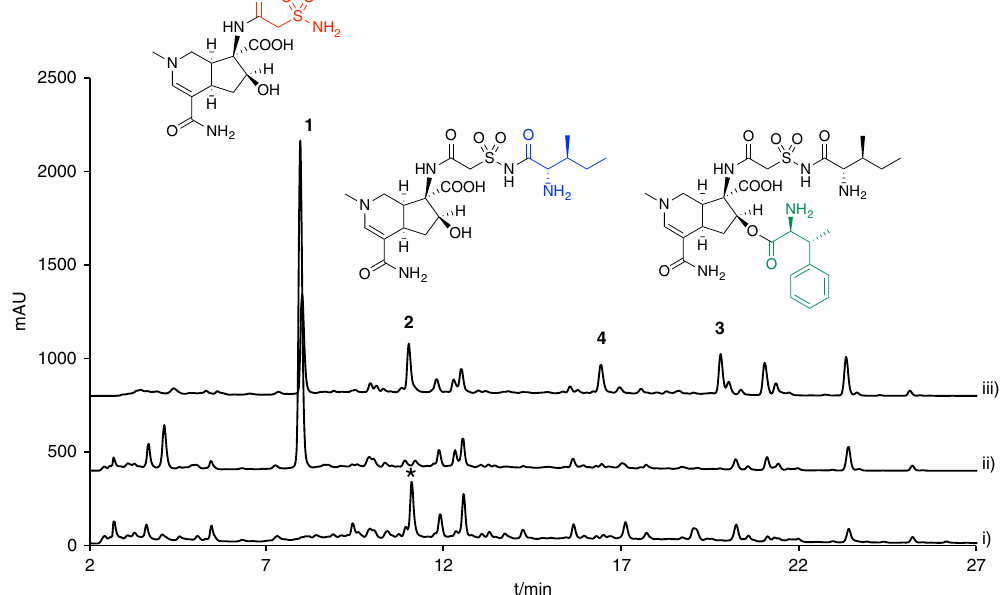
Fig. 2 HPLC analysis (monitored at 300 nm) of the water extracts from the S. lividans strain expressing sbz gene cluster. The HPLC traces of the extracts from i) S. lividans TK21, ii) S. lividans TK21/ sbz1 , and iii) S. lividans TK21/ sbz1&2 . * indicates the compound with 275 nm UV max which is not relevant to 1 – 4